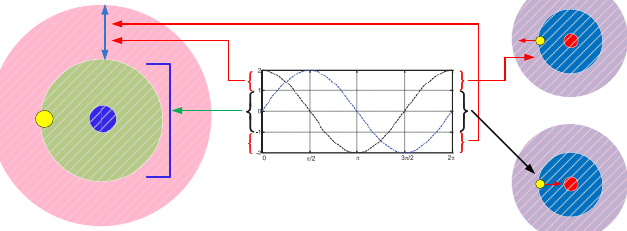
Figure 7. Sine and cosine functions within the range of [ space among them) or beyond (outside the space among them) the target